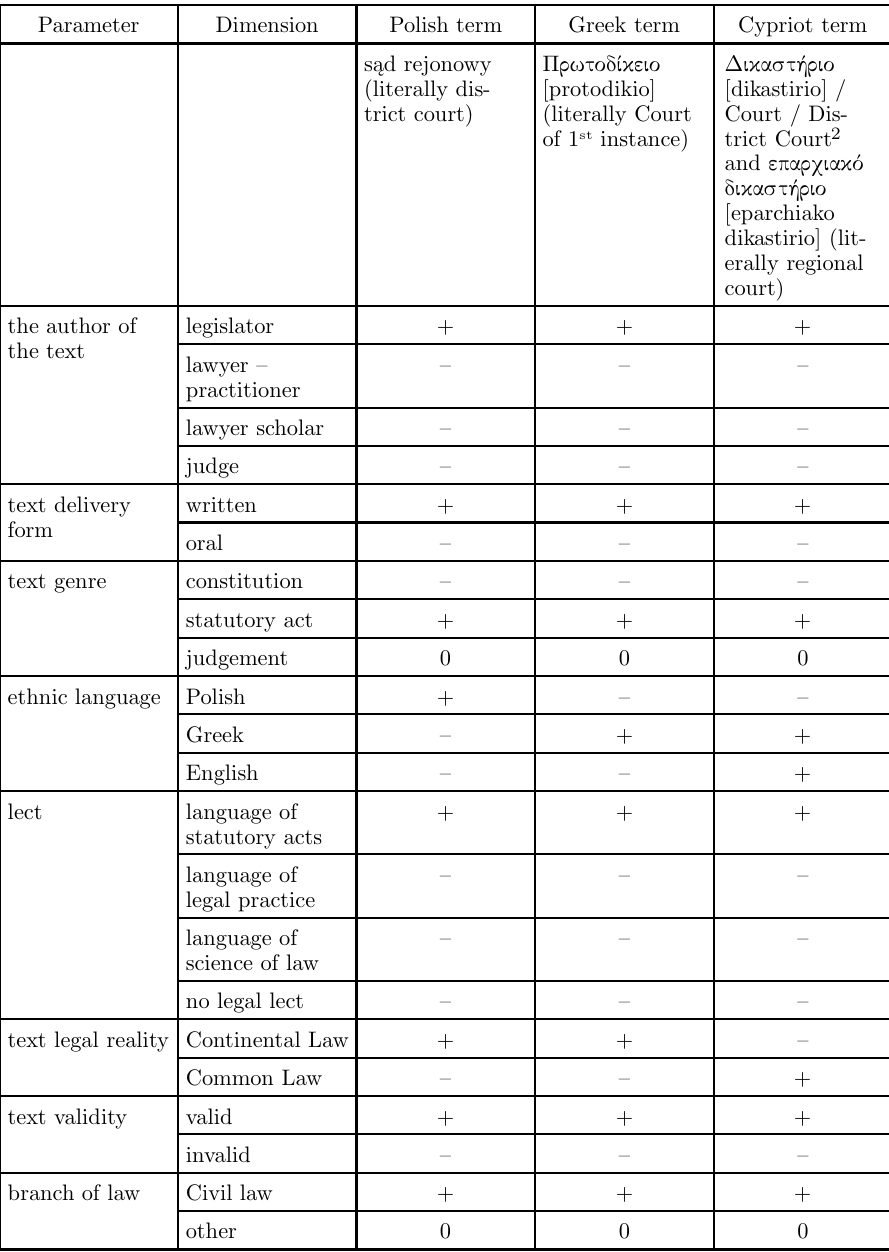
Table 1 st Court of 1 instance. Parametric analysis Parameter